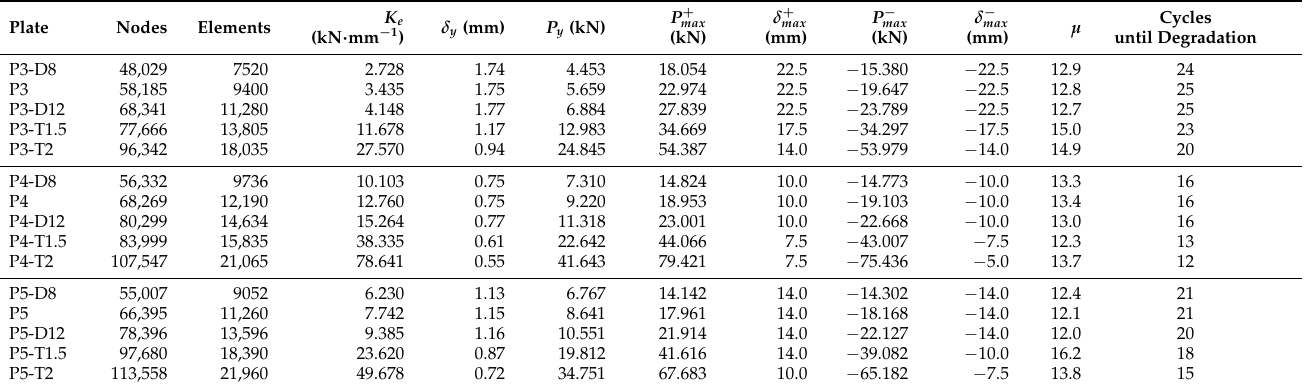
Figure 10. Influence of depth (D) and thickness (T) on the behavior of dampers P3, P4 and P5. D10 is the original design of each plate. Table 4. Summary of the numerical analysis of the parametric variations of depth and thickness of the